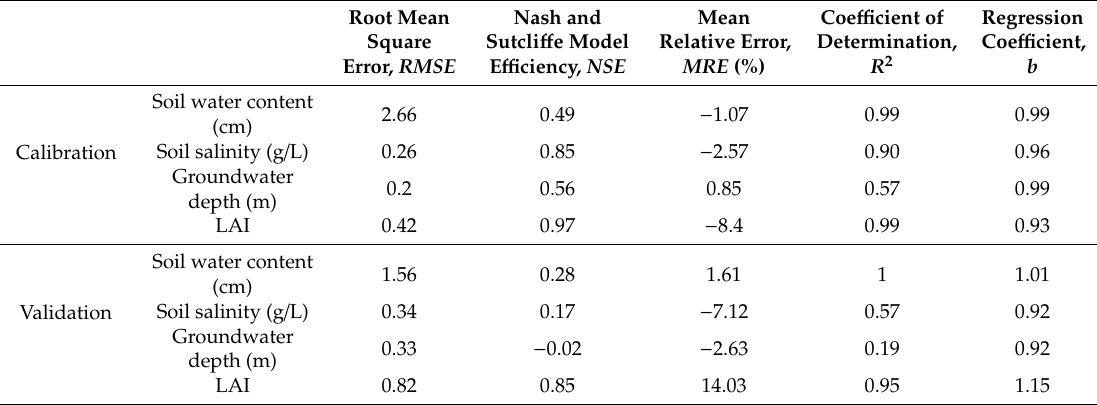
Table 5. Mean relative error, Root mean square error, Regression coe ffi cient, Nash and Sutcli ff e model e ffi ciency and Coe ffi cient of determination of the model calibration and